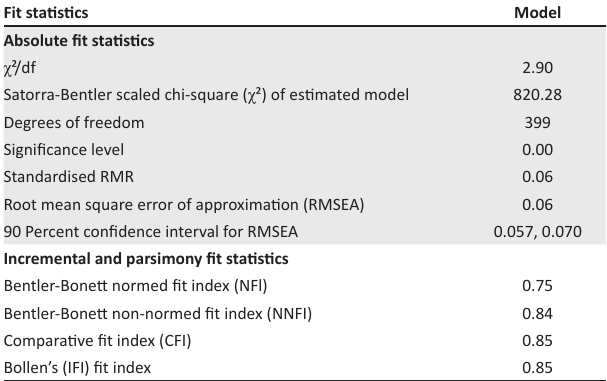
TABLE 5: Overall structural model fit measures: Robust maximum